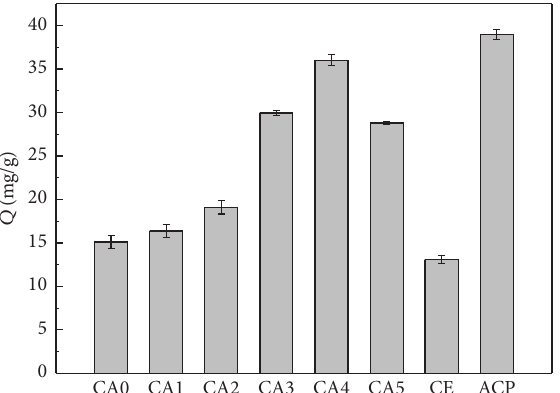
Figure 5: Adsorption capacities of CA0, CA1, CA2, CA3, CA4, CA5, CE, and